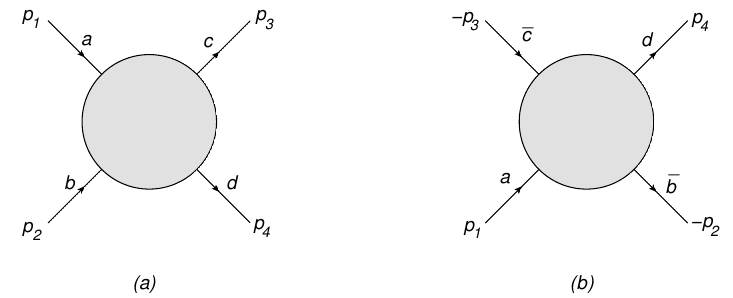
} and particle species i